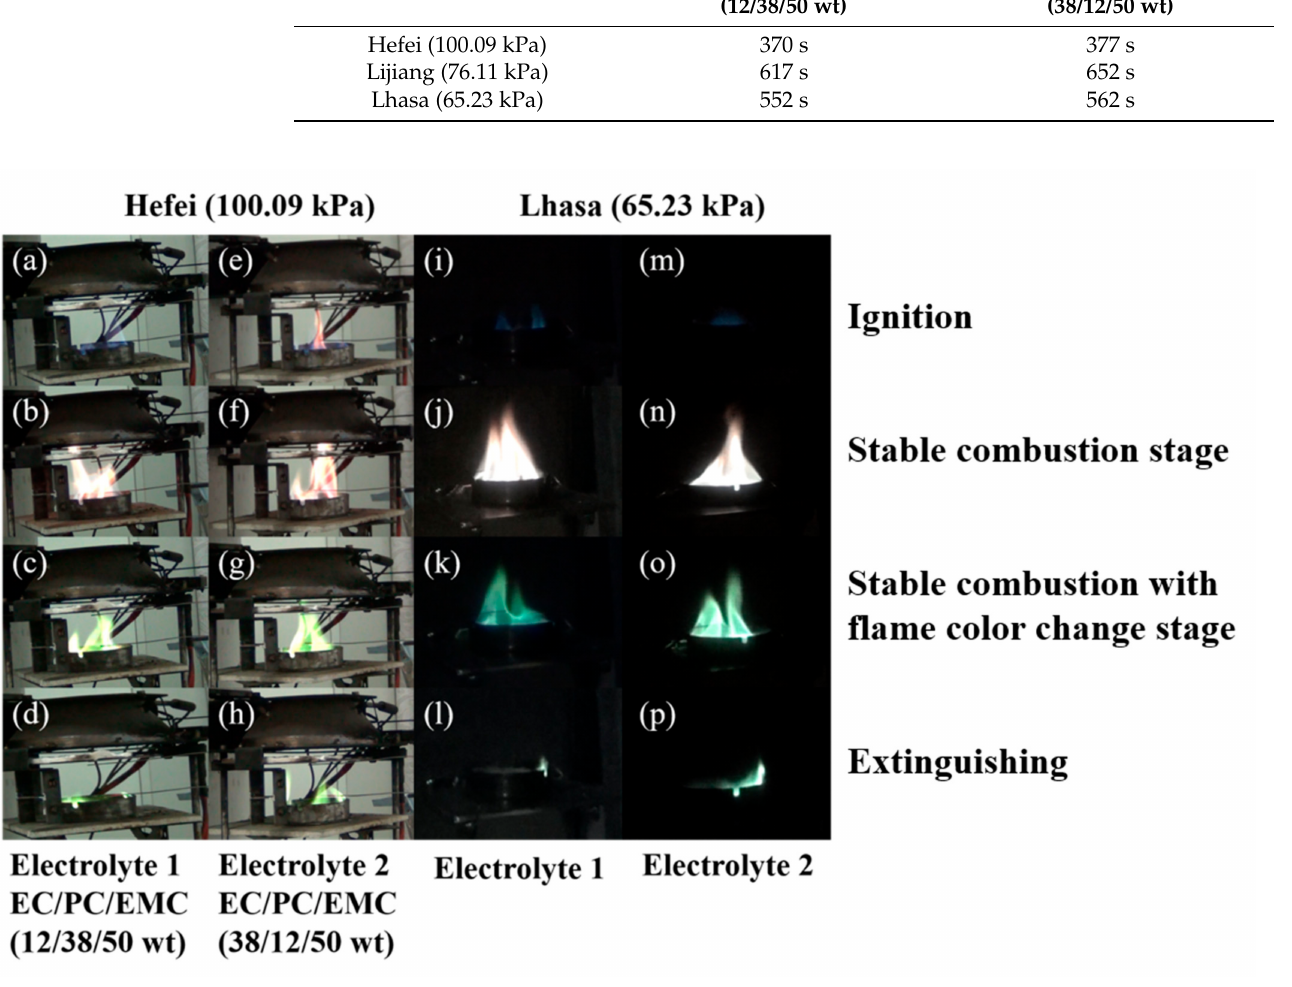
Figure 3. Experimental phenomena of two electrolytes in Hefei (100.09 kPa): ( a – h ) and Lhasa (65.23 kPa): ( i – p